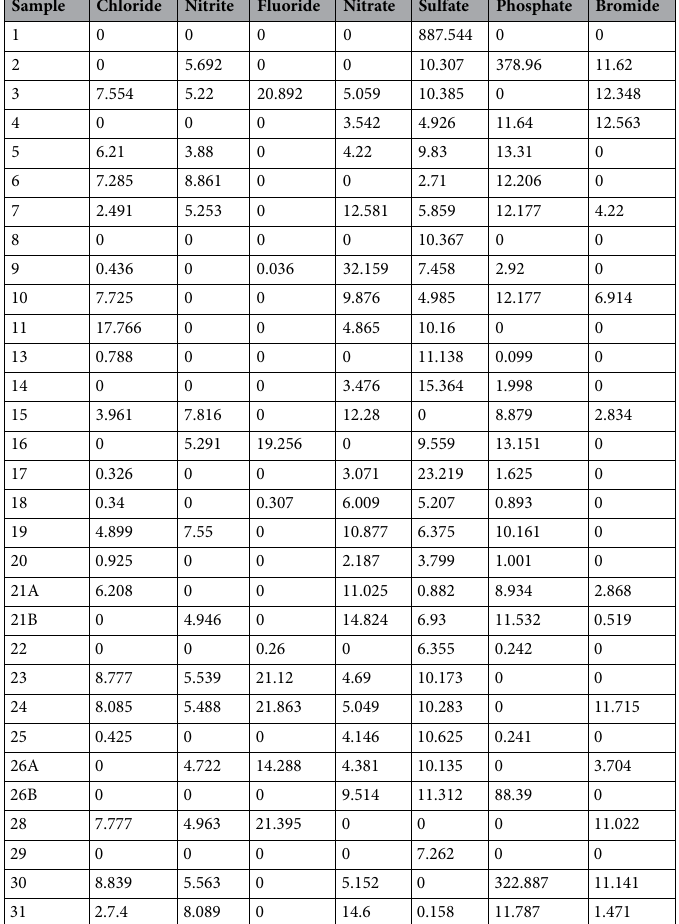
Table 3. List of anions detected by ion